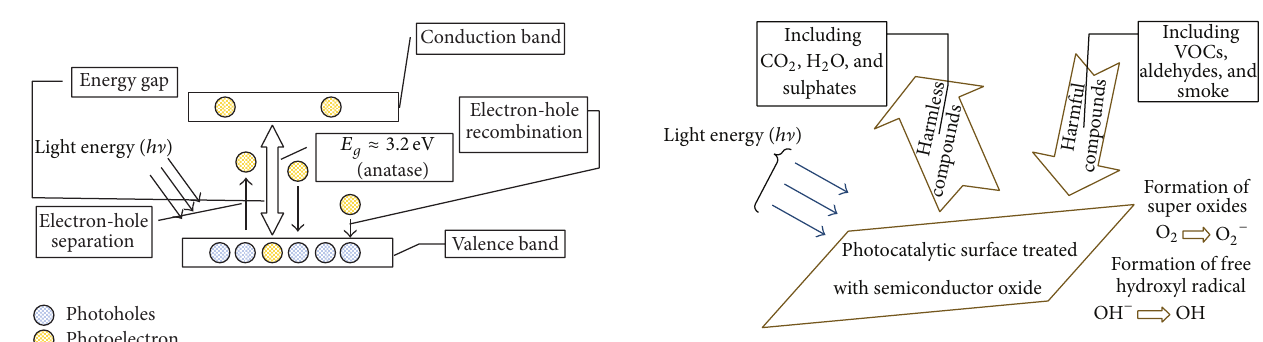
Figure 6: Mechanism of decontamination of